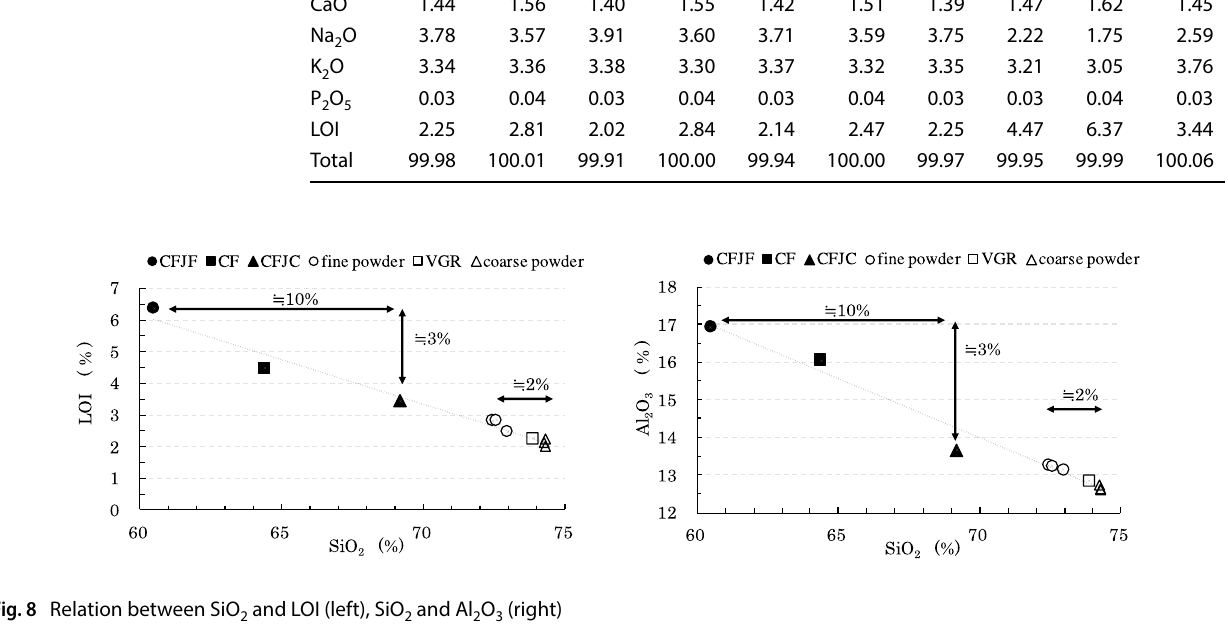
and LOI (left), SiO 2